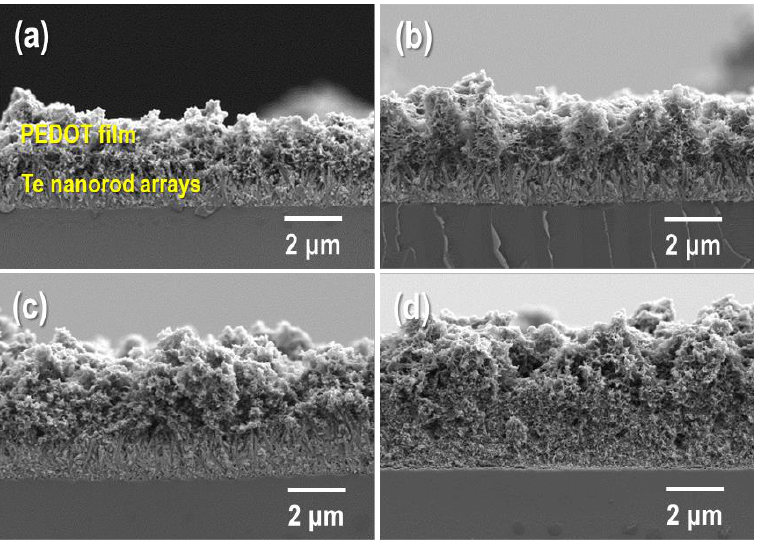
Figure 4. Cross-section FE-SEM images of PEDOT/Te composite films fabricated at the electrochemi- cal polymerization time of ( a ) 15 s, ( b ) 30 s, ( c ) 60 s, and ( d ) 90 s,